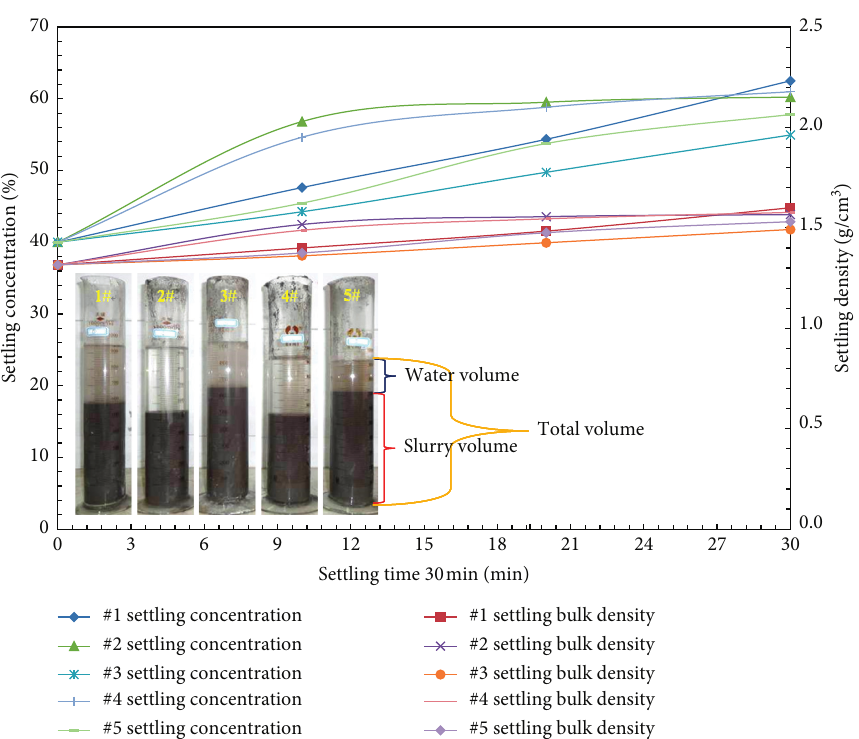
Figure 13: Curves of settling concentration and bulk density